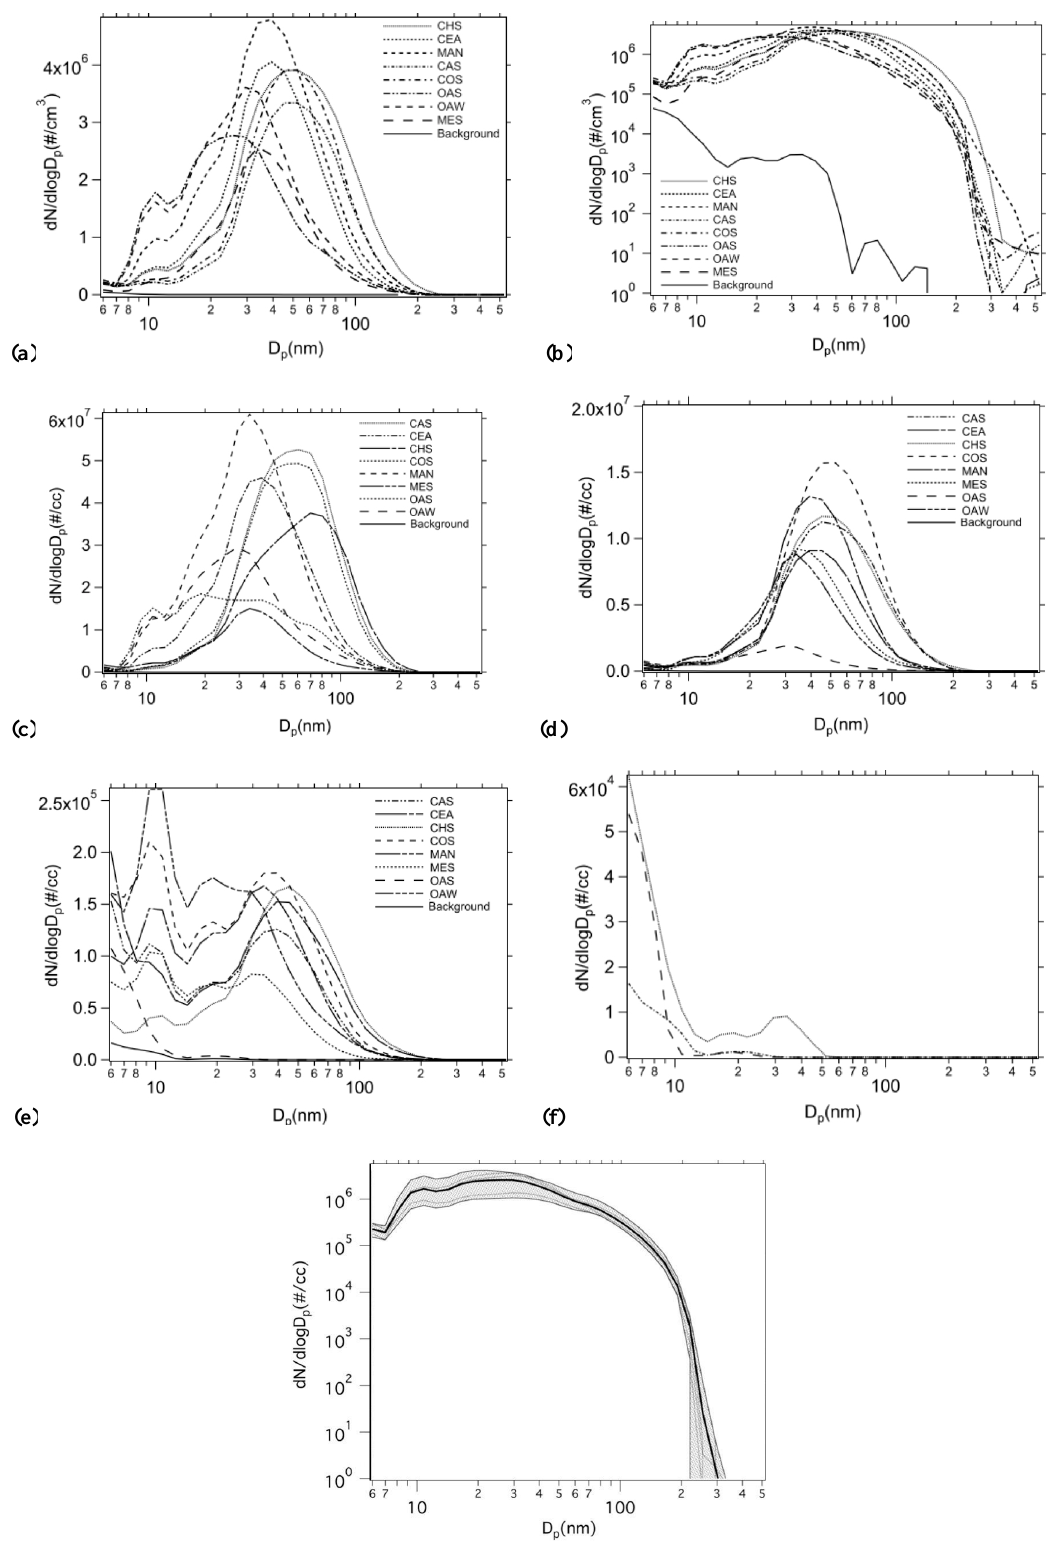
Fig. 4. Particle size distributions corresponding to (a) whole burn (linear) (b) whole burn (log-log) (c) Flaming, (d) Mixed, and (e) Smoldering phases (f) presents background levels measured by FMPS (g) variation of